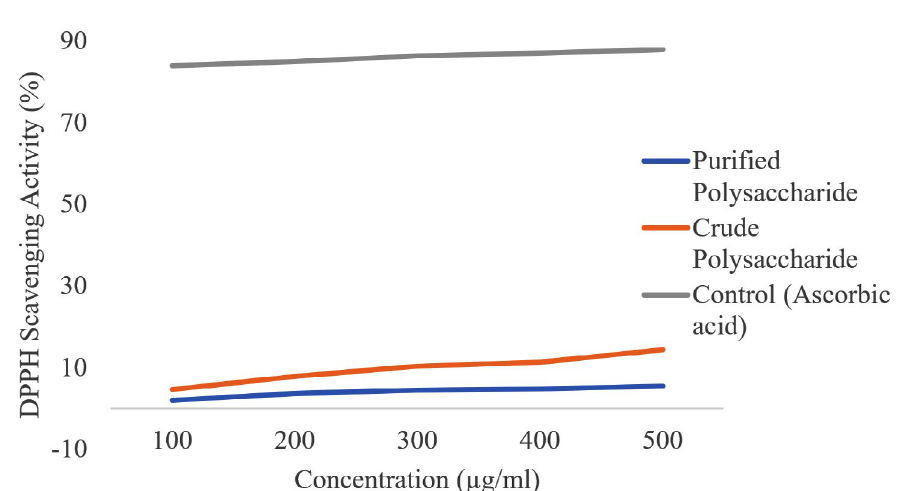
Fig. 5. A comparison of DPPH scavenging activity between purified polysaccharide, crude polysaccharide and ascorbic